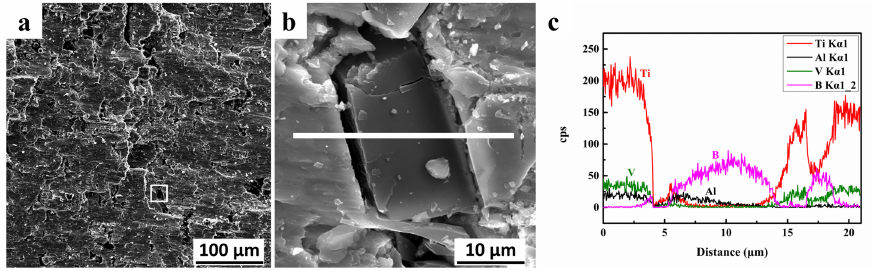
Figure 11. ( a , b ) The compression fracture surface of the sample with C-B addition; ( c ) EDS line of the selected